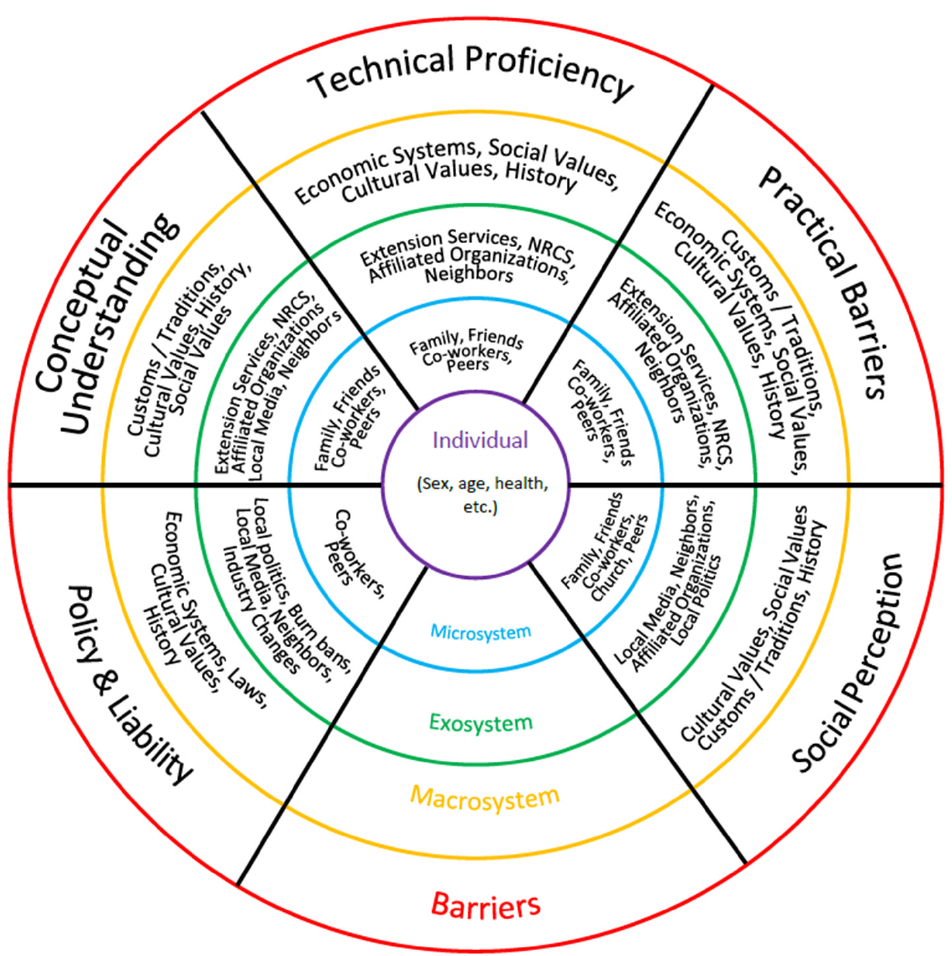
Figure 1. The adapted ecological systems model provides fire practitioners and researchers with a framework for understanding the multiple scales at which barriers to prescribed fire use occur. The microsystem represents the groups that most directly interact with and influence the individual. The exosystem represents the indirect community and industry of an individual. The macrosystem represents the history and values of the culture and country in which the individual exists.